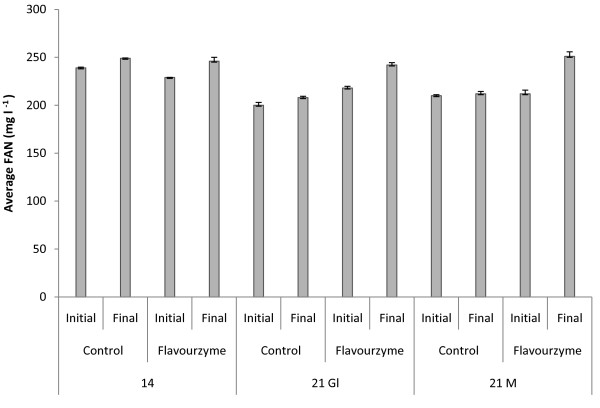
Results from the FAN measurements of initial and final samples collected during enzyme hydrolysis assays. The values are average of duplicate measurements with standard deviation < 10%.